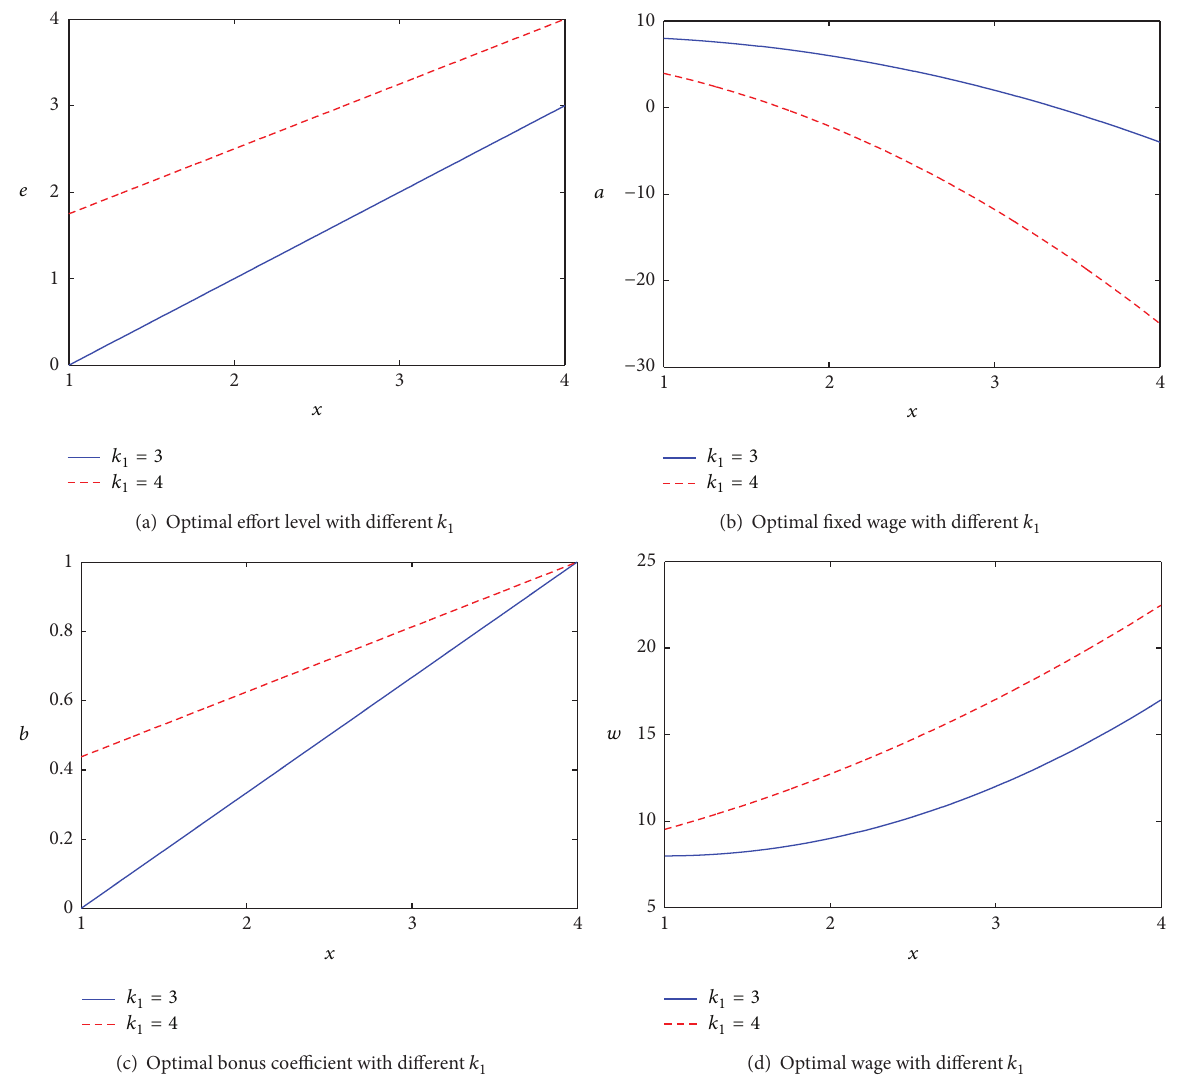
Figure 1: Optimal contract with different parameter 𝑘 1